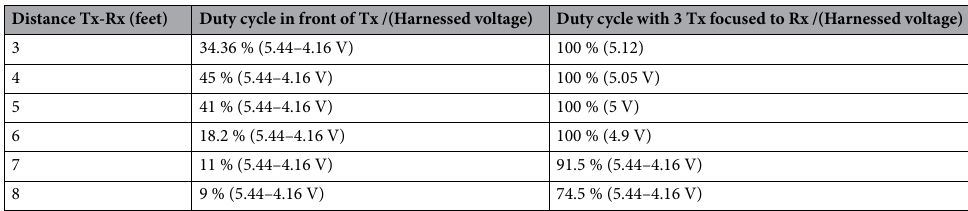
Table 3. Duty cycle and voltage of DC signal at the output of receiver while receiver is placed in front of single transmitter (2nd row) and while all three transmitter is focused on the receiver (3rd row).